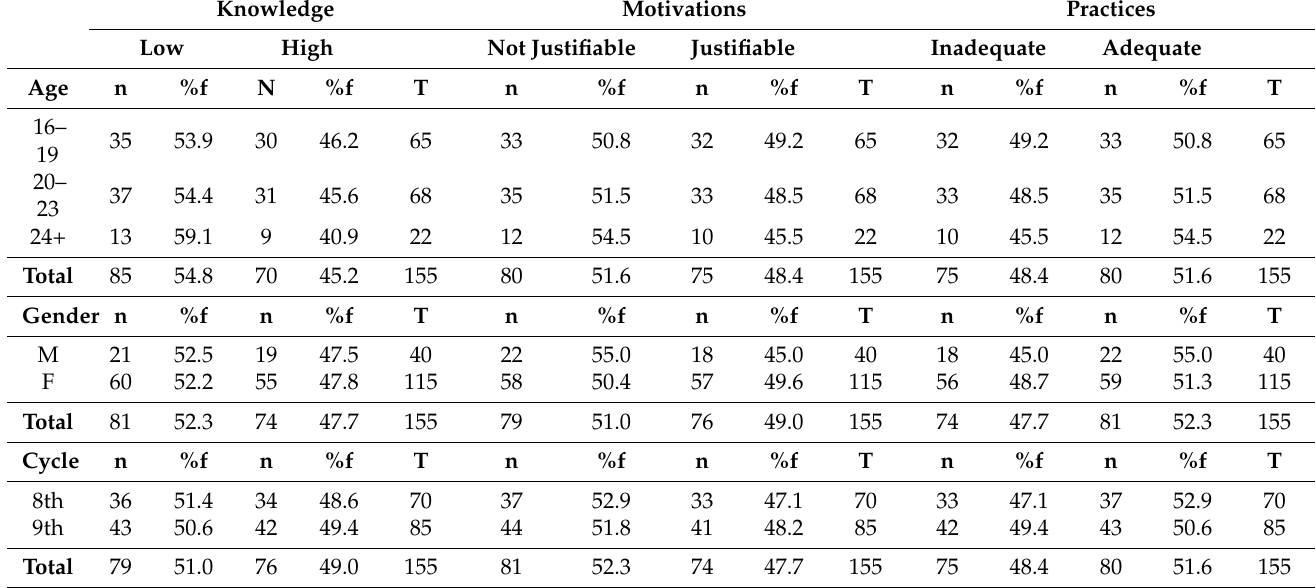
Table 8. Level of perception of the dimensions of academic plagiarism in students of the industrial engineering career at a public university in Lima according to the age, gender and cycle of